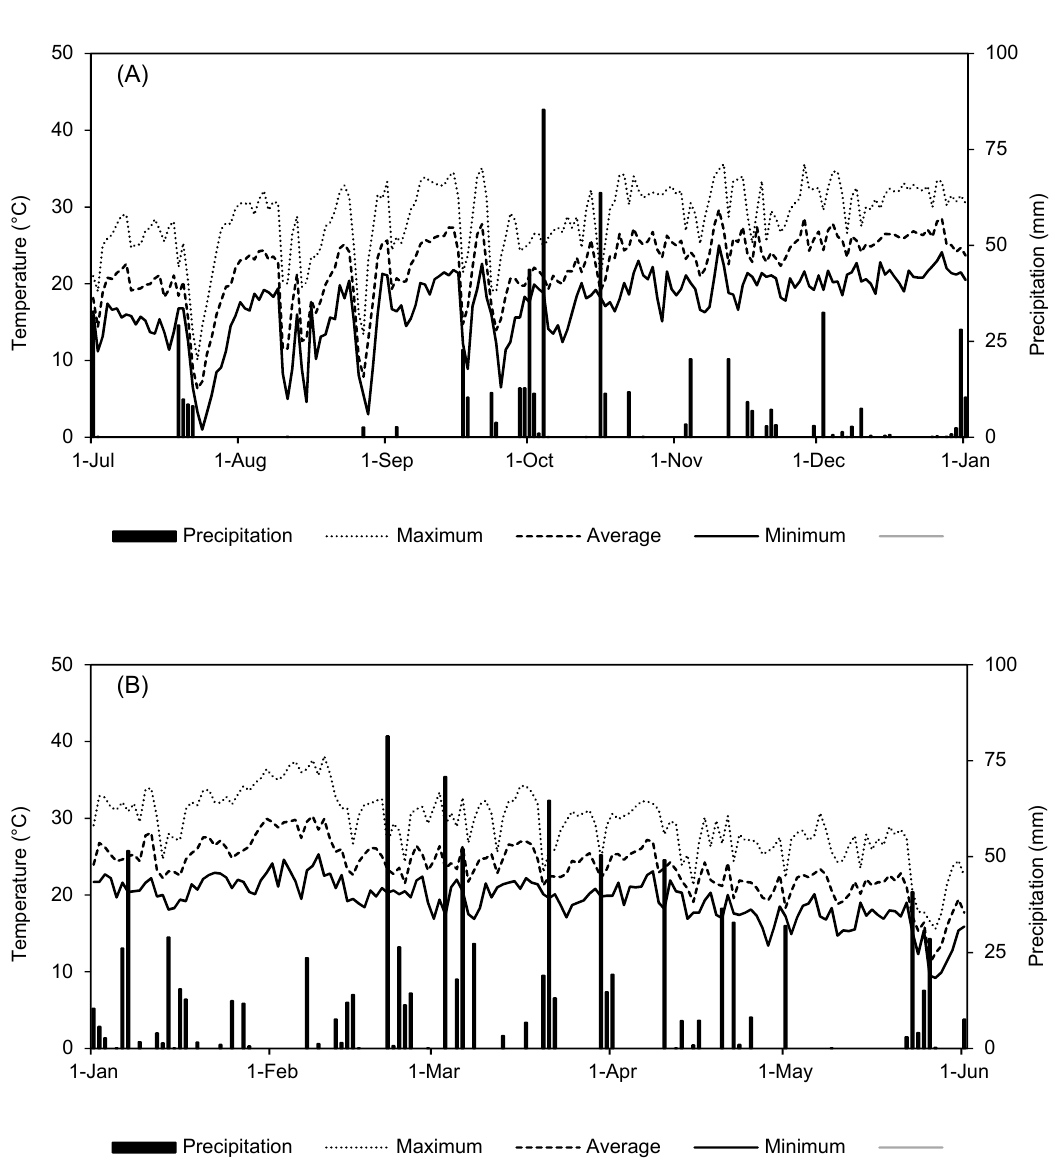
Figure A1. Precipitation (mm), maximum, average and minimum temperature during ( A ) the summer crop season 2013, and ( B ) off-season 2014. Source: Instituto Nacional de Meteorologia– INMET.